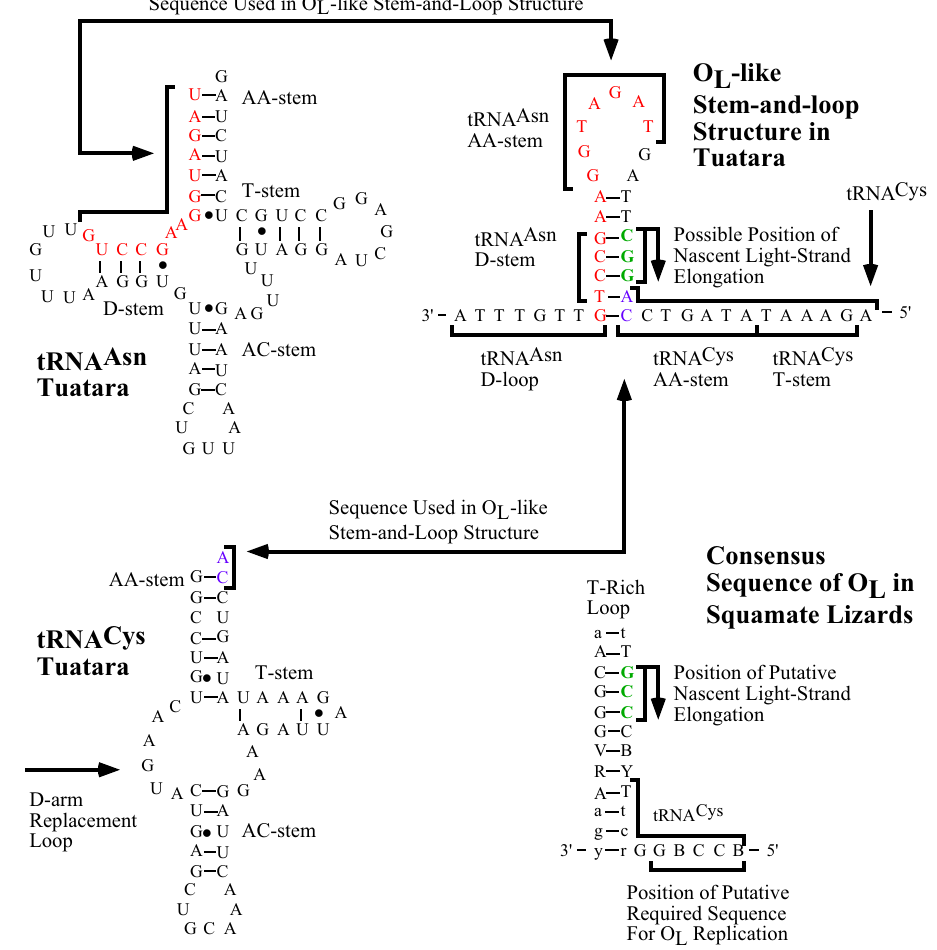
Fig. 4 Secondary structures in the region of the light strand replication origin (O L ) in the Tuatara ( Sphenodon punctatus ). Top right is a stem-and-loop structure that may serve as O L but is highly unusual (presented as heavy-strand template DNA sequence). This O L -like structure overlaps 14 bases with tRNA Asn (normally no overlap) and two bases with tRNA Cys (normally two to four), (see arrows and lower right for O L comparison). Putative light-strand encoded tRNAs are presented to the left and are the same sequence as heavy-strand DNA except for the use of U instead of T. The Tuatara has an unusual tRNA Cys that lacks a D-stem and instead contains a D-arm replacement loop (arrow) 19,20 . Stems are as follows: AA = amino-acid acceptor stem, D = dihydrouridine stem, AC = anticodon stem, and T = TphiC stem. Consensus heavy-strand sequence of putative O L from squamate lizards is presented in the lower right. This sequence is based on representatives from the Iguanidae (nine genera), Gekkonidae ( Teratoscincus ), Dibamidae ( Dibamus ), Lacertidae ( Eremias ), Teiidae ( Cnemidophorus ), Cordylidae ( Platysaurus ), Anguidae ( Elgaria ), Xenosauridae ( Xenosuurus ), and Varanidae ( Varanus ); 6,54 Dibamus novaeguineae , U71327, was previously reported as Lialis jicari 6 . Bases in capitals are conserved pairings and downstream sequences. Bases in lower case are often paired. Variable positions are labeled with their standard one-letter codes: R = G or A; Y = C or T; B = G, C, or T; and V = G, C, or A. The 3 ’ -GCC-5